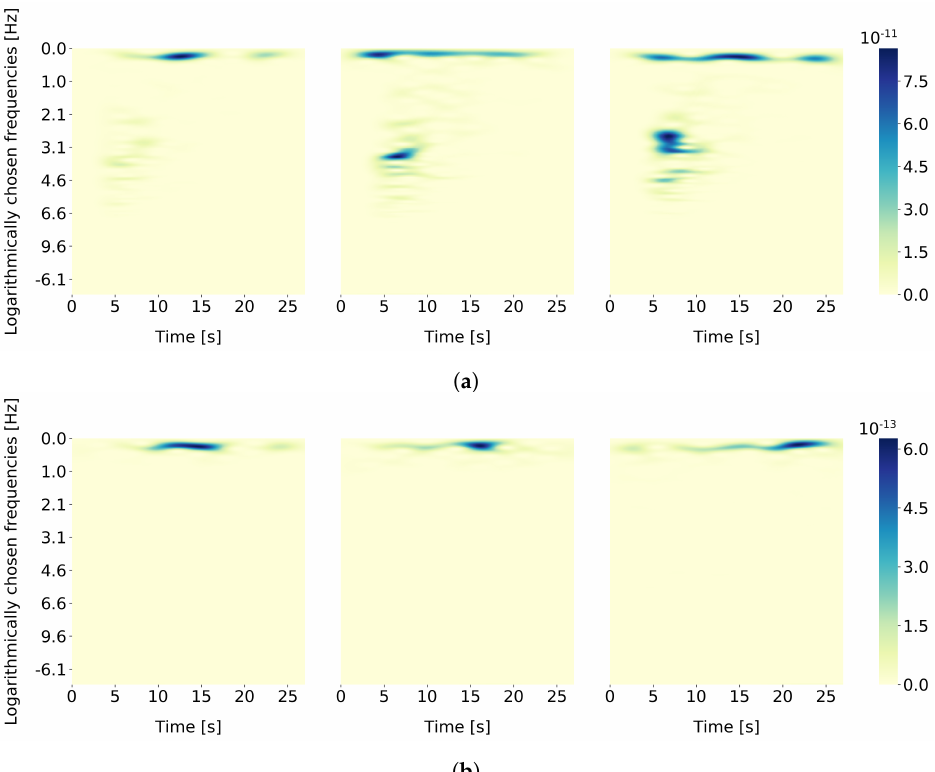
Figure 5. Margenau–Hill transformations of ( a ) an earthquake and ( b ) noise shown in Figure 2. All three axes are presented.